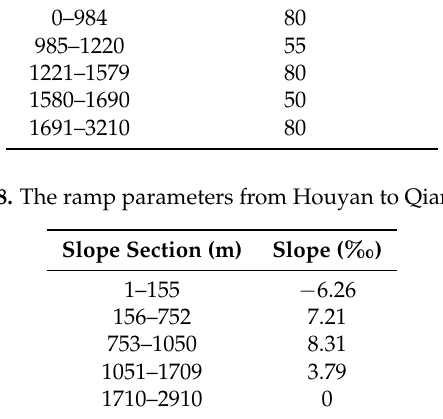
Table 7. The speed limit from Dalian North Station to Houyan. Section (m)